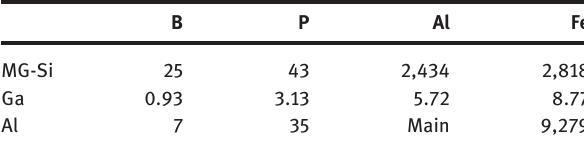
Table 1: Mass fraction of impurities in MG-Si, Ga and Al (ppmw).